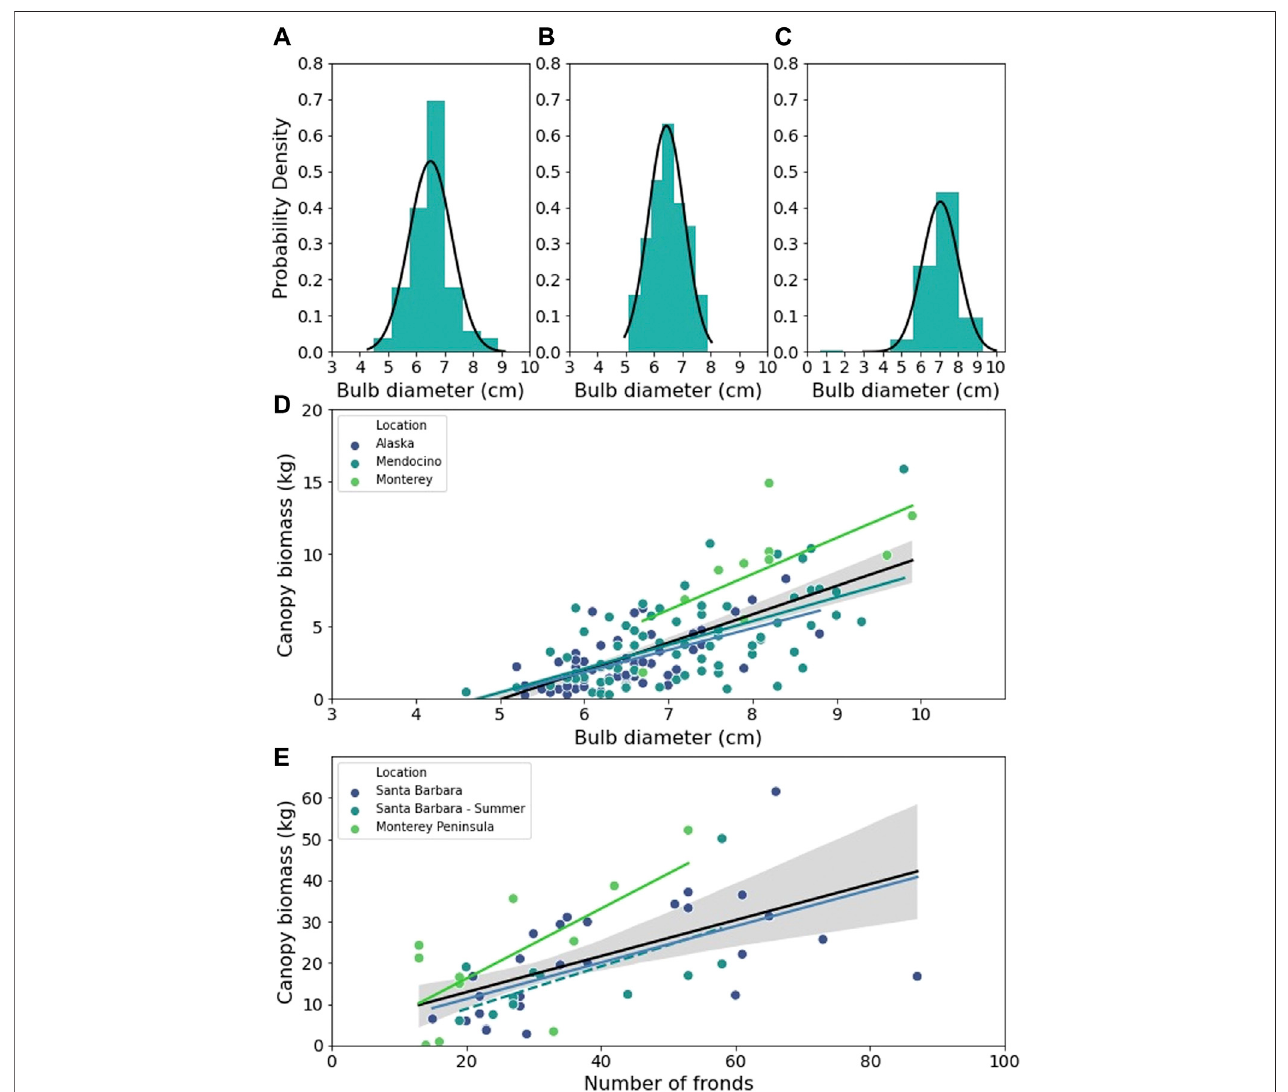
FIGURE 6 | The probability distribution of bull kelp bulb diameter for (A) Noyo Harbor, (B) Portuguese Beach, (C) Point Piños. (D) Scatter plot of wet bull kelp canopy biomass against bulb diameter fi tted with OLS linear regressions for Alaska (blue line), Mendocino (teal line), Monterey (green line), and all regions combined (black line). (E) Scatter plot of wet giant kelp canopy biomass against frond number fi tted with OLS linear regressions for all data from Santa Barbara, CA (blue line), summer data from Santa Barbara (blue dashed line), Monterey, CA (green line), and all regions combined (black line). Regression details listed in Supplementary Table S1 . Grey shaded areas represent regression 95% CI.